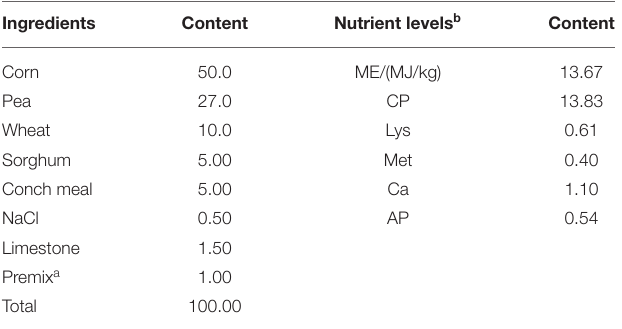
TABLE 1 | Composition and nutrient levels of the basal diet (as-dry basis) %.